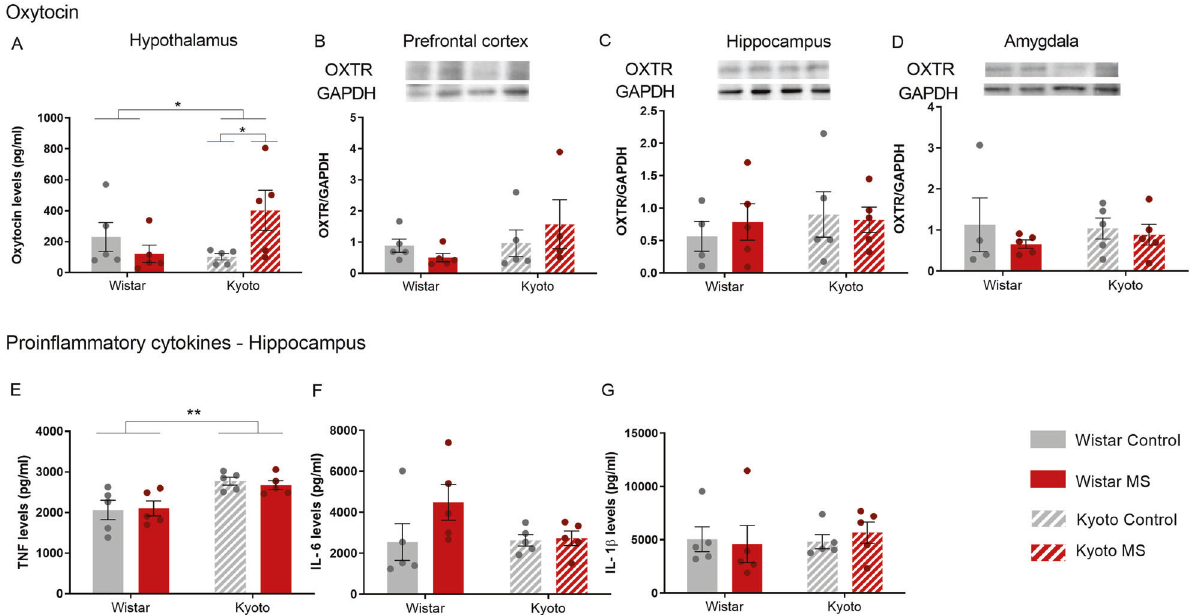
Fig. 4 Maternal separation disturbed mothers ’ neurobehavior. After weaning, MS increased Kyoto A oxytocin levels, in agreement with the decrease of anxiety observed. E Kyoto showed high levels of TNF than Wistar strain. Quanti fi cation of A oxytocin (pg/ml) levels in hypothalamus by ELISA; OXTR in B PFC, C hippocampus, and D amygdala by Western blotting; E TNF (pg/ml), F IL-6 (pg/ml), and ( G ) IL-1 β (pg/ ml) levels in hippocampus by ELISA. Data were analyzed by two-way ANOVA (2 × 2 factorial design) with Bonferroni comparisons. A – C , F , G data were log-transformed. n = 5, except for B MS Kyoto, and C , D for control Wistar: n = 4. Results are expressed as mean ± SEM. * p < 0.05, ** p < 0.01, *** p < 0.001. MS = maternal